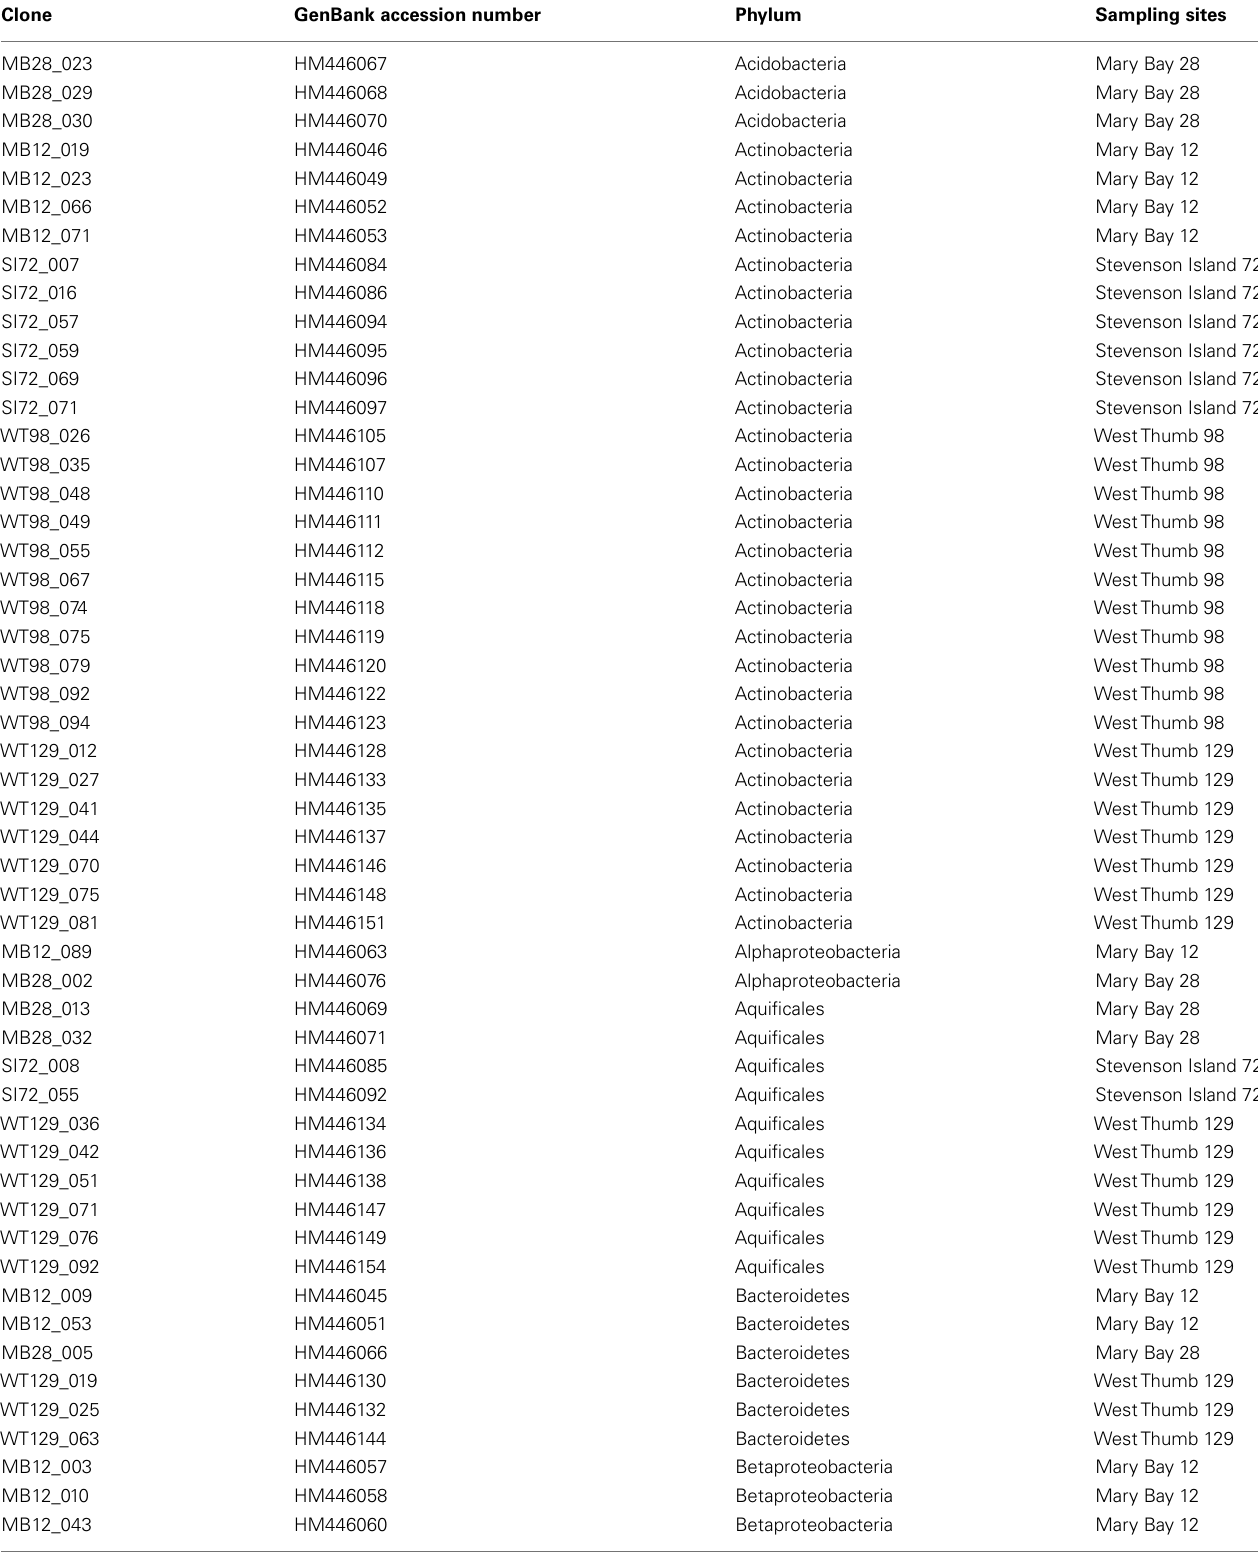
Table 2 | List of clone names, Genbank accession numbers, phylogenetic affiliation, and sample of origin.